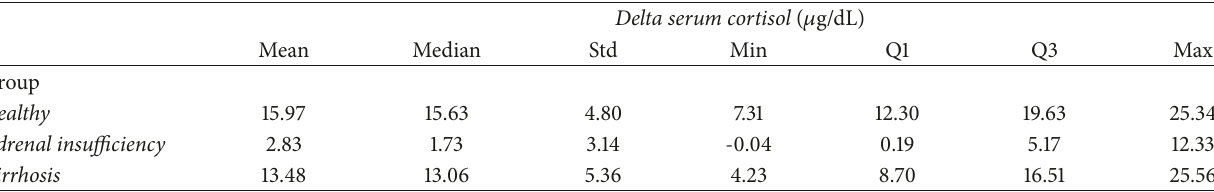
Table 3: Change in serum cortisol between baseline and 60 minutes in healthy volunteers, adrenal insufficient patients, and cirrhotic patients in the 250 𝜇 g ACTH test.